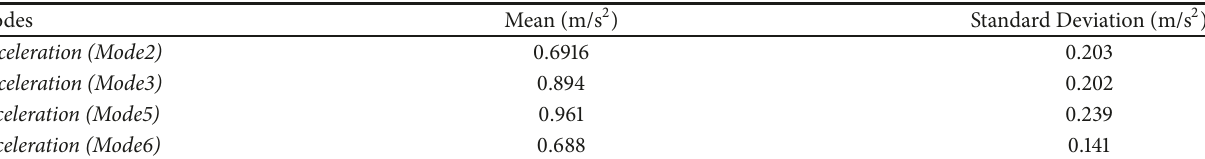
Figure 6: Different sample scenarios for deceleration process. Table 1: Parameters for each mode.